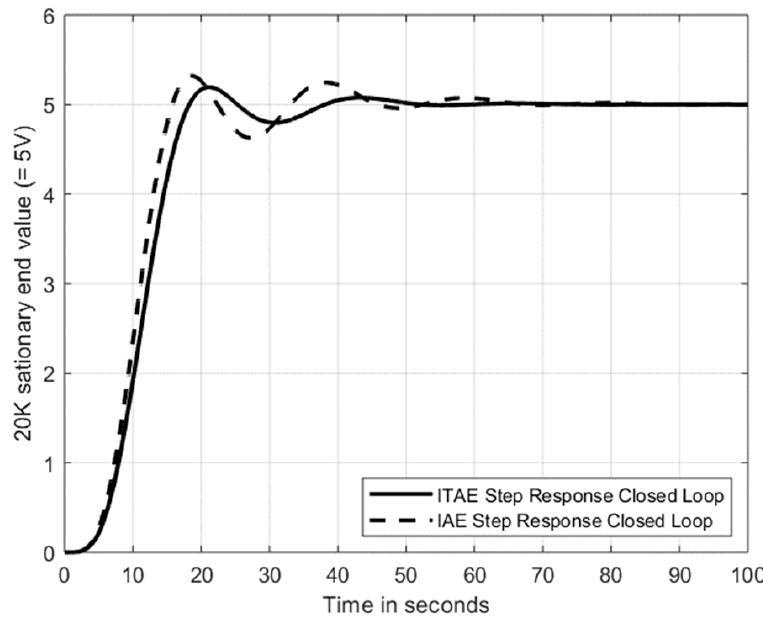
Figure 10. PID control of the PT5 heating chamber, according to the optimal parameters for the IAE and ITAE criteria.